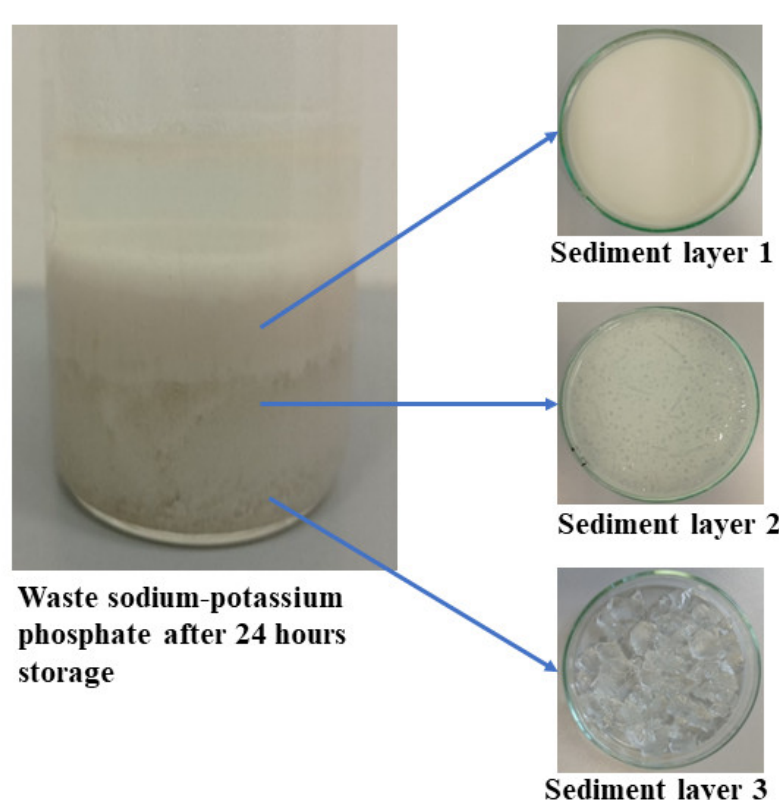
Figure 1. Sludge layers in waste phosphate with different crystal sizes.